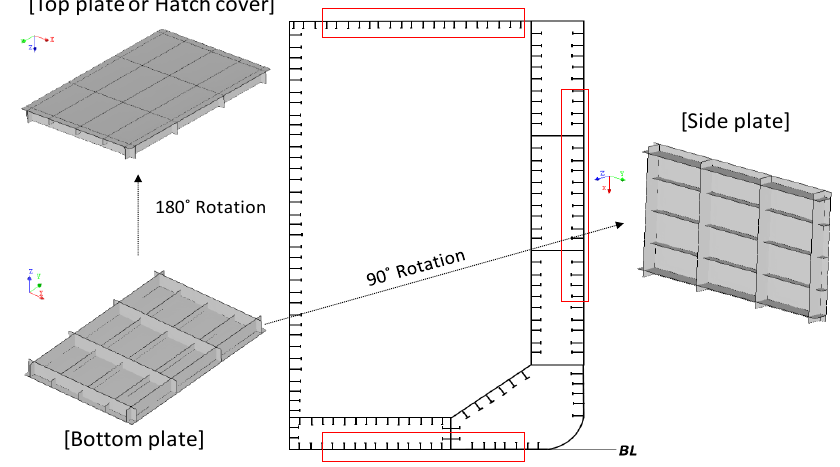
Figure 1. Change in the gravitational orientation of welded structures.